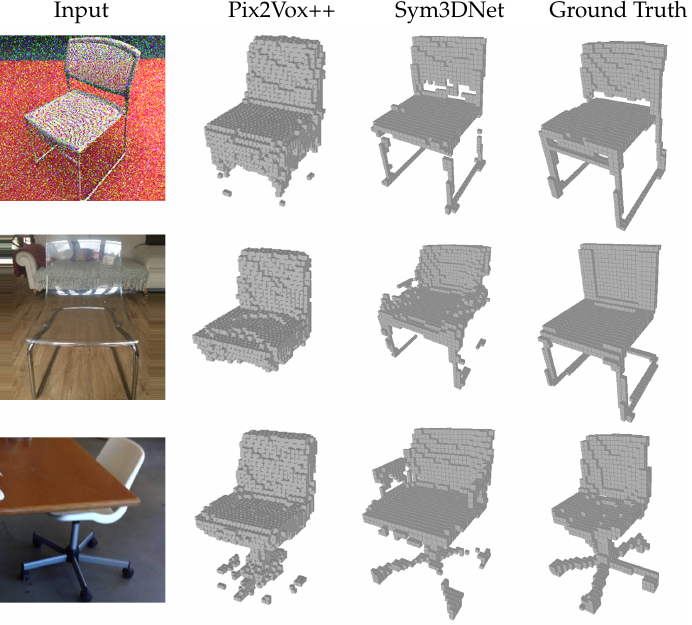
Figure 8. Single view reconstruction of proposed method on challenging situations such as noisy input, occluded and transparent